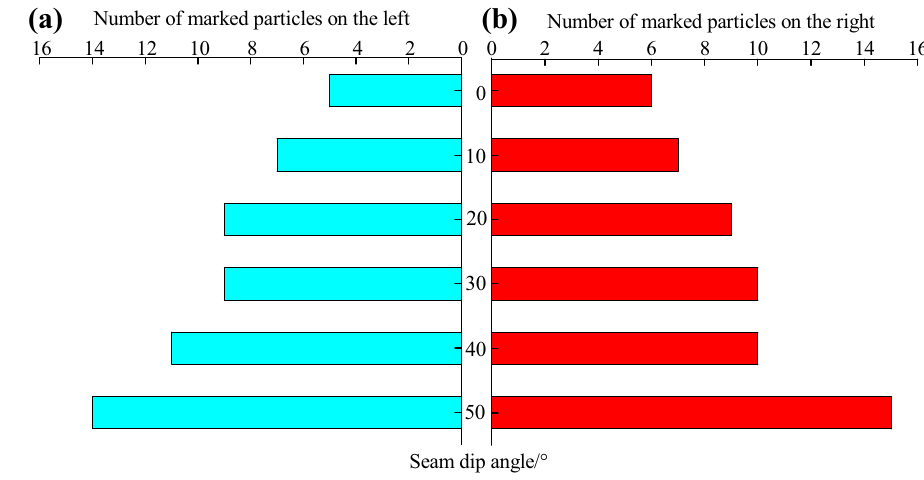
Fig. 5 Numbers of drawn marked particles on a the left side and b the right side in the initial drawing